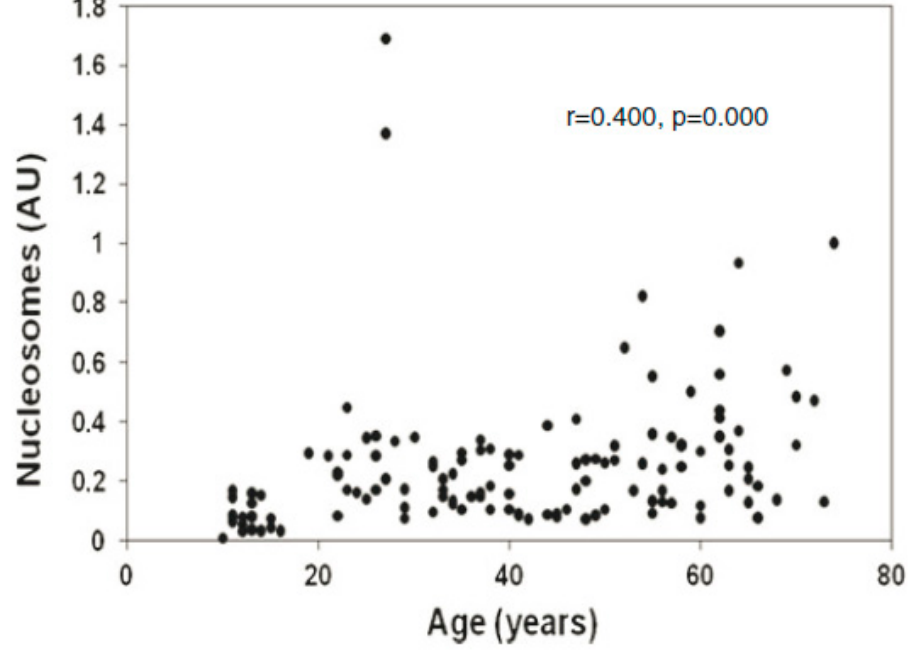
Figure 1. Levels of cell-free chromatin (cfCh) in serum increase with age. The study included 140 healthy subjects aged 15–70 years. The cfCh levels were measured using the Cell Death Detection ELISAPlus kit (Roche Apllied Sciences, Mannheim, Germany). Values are expressed as arbitrary units (AU). Reproduced from [62].